Question: What type of chart is this?
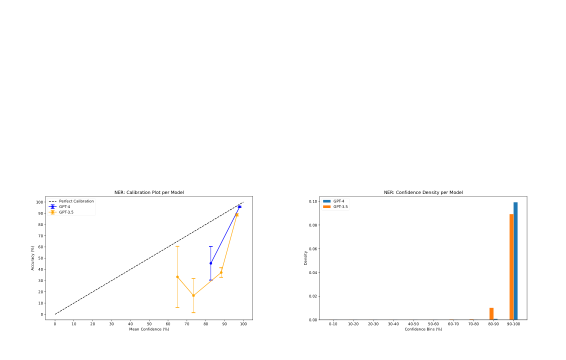
Answer: histogram